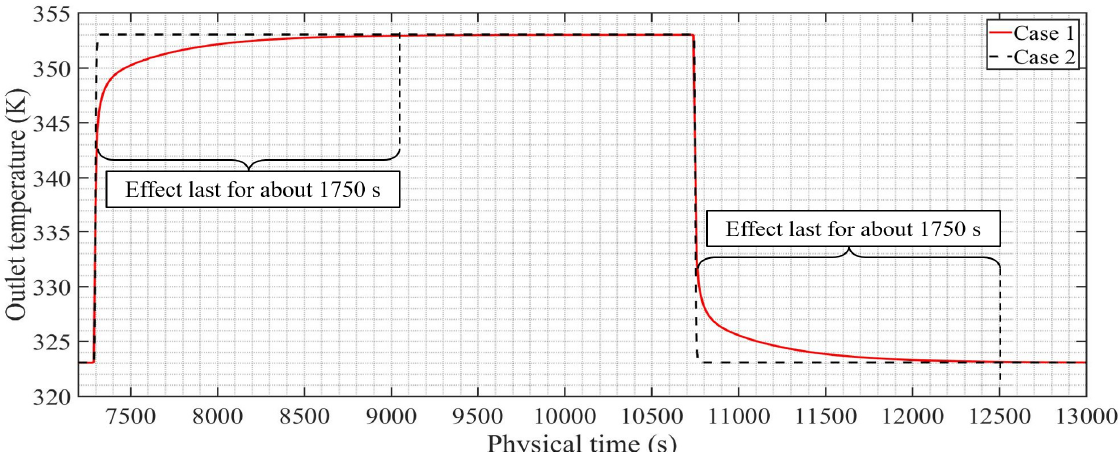
Figure 22. Comparison of Case 1 and Case 2 (with constant mass flow of 282.74 kg/s).